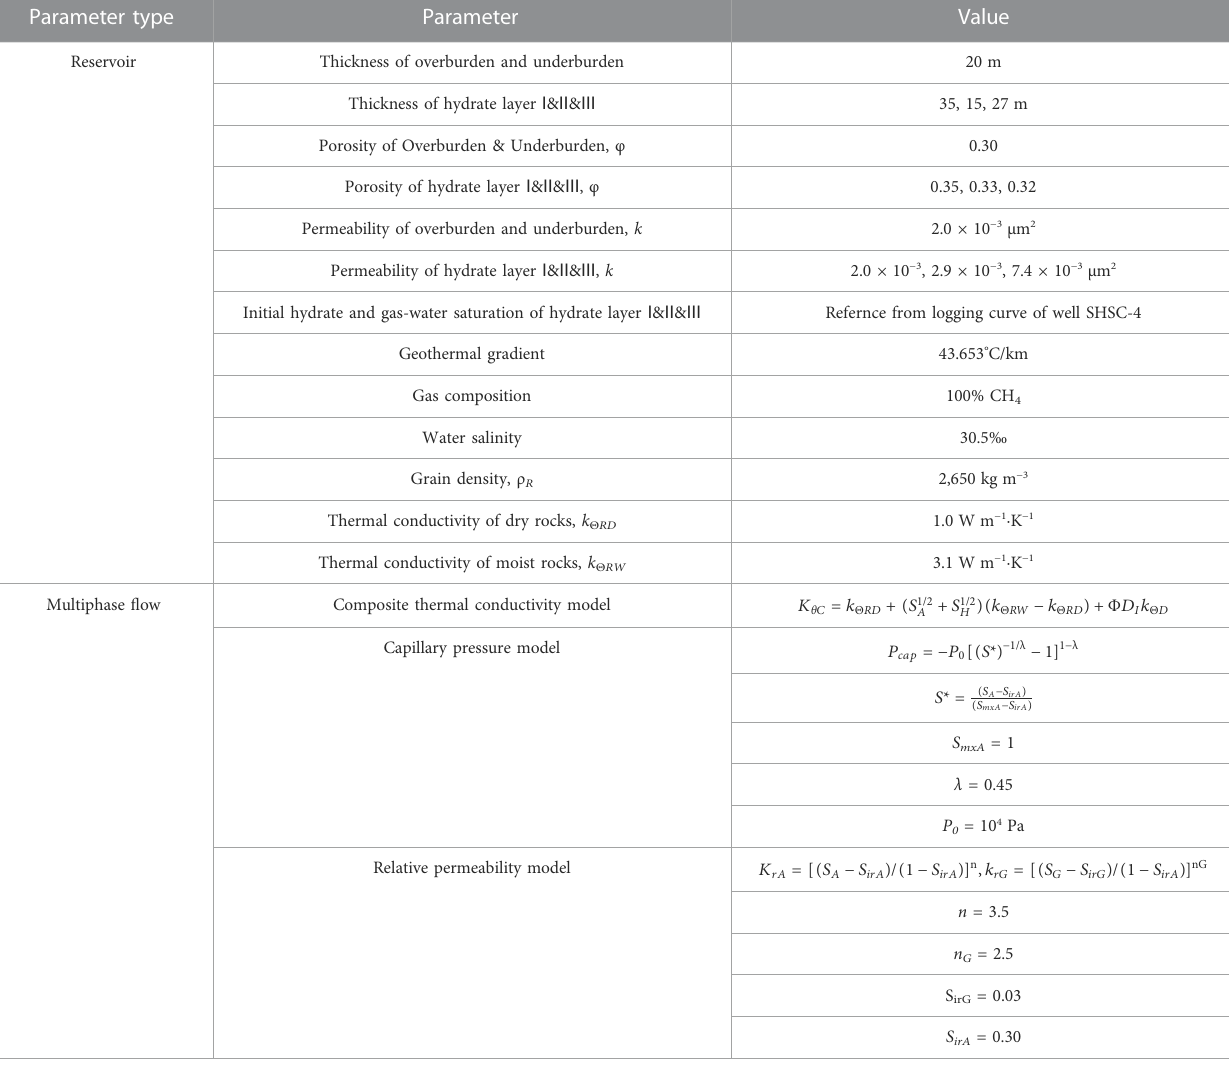
TABLE 1 Simulation calculation parameters and reservoir characteristic parameters.